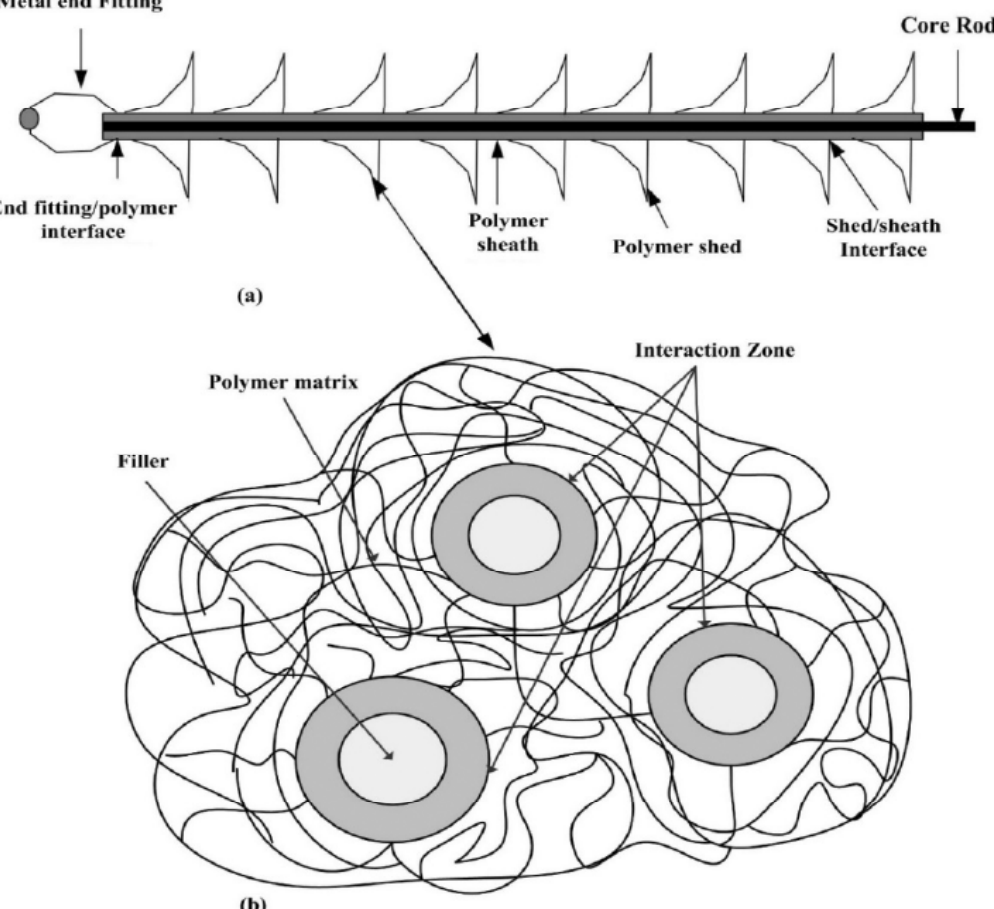
Fig. 14. (a) Composite insulator profile, (b) Weathershed material